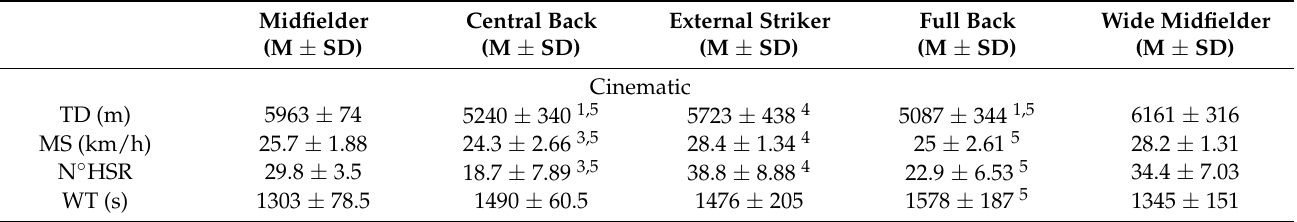
Table 4. External load indicator differences among playing positions (central back, external striker, full back, midfielder, wide